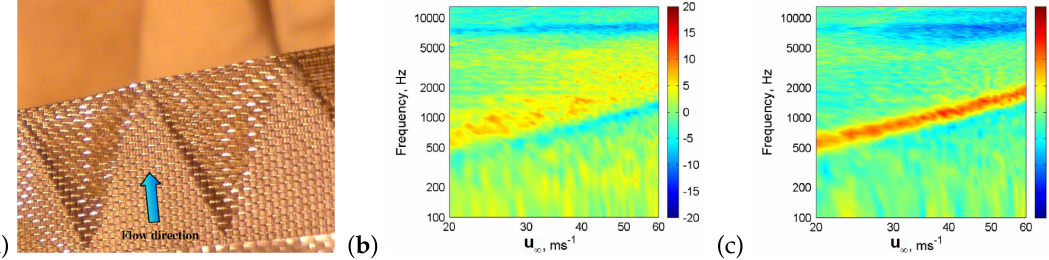
Figure 12. Photographs of the serrated trailing edges attached with woven-wire mesh screen ( a ); and color maps of the ∆ SPL between serrated and baseline trailing edges ( b ) or ∆ SPL between serrated and poro-serrated trailing edges ( c ), where positive dB value represents noise reduction. Reprinted from [97] with permission from